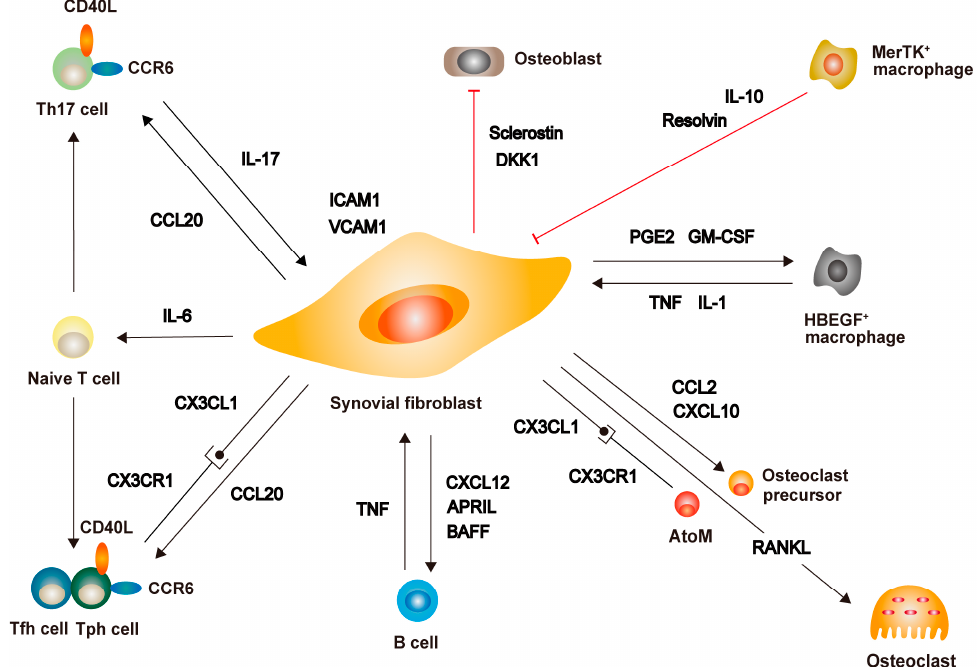
Figure 3. Cross-talk of synovial fibroblasts and immune cells. Synovial fibroblasts interact with a variety of immune cells. T cells expressing CD40L upregulate the expression of intercellular adhe- sion molecule 1 (ICAM1) and vascular cell adhesion molecule 1 (VCAM1), to promote the produc- tion of interleukin-6 (IL-6) by synovial fibroblasts. IL-6 produced by synovial fibroblasts, in turn, promotes the differentiation of T helper 17 (Th17) cells producing IL-17 and T follicular helper (Tfh)/T peripheral helper (Tph) cells producing autoantibodies. Chemokine (C-C motif) ligand 20 (CCL20) and chemokine (C-X3-C motif) ligand 1 (CX3CL1) from synovial fibroblasts recruit chem- okine (C-C motif) receptor 6 (CCR6)- and chemokine (C-X3-C motif) receptor 1 (CX3CR1)- positive T cells to the inflamed synovium. The tumor necrosis factor (TNF) from B cells stimulates synovial fibroblasts, chemokine (C-X-C motif) ligand 12 (CXCL12) from synovial fibroblasts supports B cell survival, and TNF ligand superfamily members 13 and 13B (APRIL and BAFF) from synovial fibro- blasts promote the differentiation and activation of B cells. Monocyte lineage cells are recruited to the inflamed synovium by the action of CCL2 and CXCL10 produced by synovial fibroblasts and differentiate into osteoclasts through the action of receptor activator of NF- κ B ligand (RANKL). Re- cently identified arthritis-associated osteoclastogenic macrophages (AtoMs) interact with synovial fibroblasts through the CX3CL1/CX3CR1 axis. Prostaglandin E2 (PGE2) and granulocyte-macro- phage colony-stimulating factor (GM-CSF) secreted by synovial fibroblasts induce the generation of pro-heparin-binding EGF-like growth factor (HBEGF)-positive macrophages, while TNF and IL-1 produced by these HBEGF-positive macrophages stimulate synovial fibroblasts. Conversely, MerTK-positive macrophages exert suppressive effects on synovial fibroblasts through IL-10 and Resolvin. Furthermore, Dickkopf-related protein 1 (DKK1) and sclerostin from synovial fibroblasts suppress osteoblast differentiation.